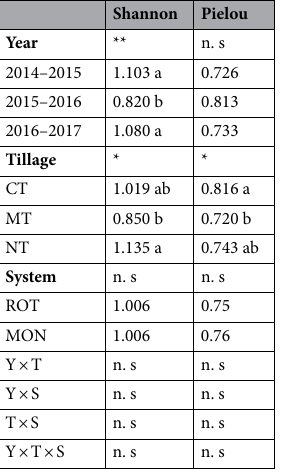
Table 4. Analysis of variance results for year, tillage system, and crop system. Mean values for Shannon and Pielou index. Different letters in each column indicate a difference between treatments according to Tukey’s HSD Test with 95% probability level ( p < 0.05); *** = 0.05; ** = 0.1; * = 0.5 CT conventional tillage, MT minimum tillage, NT no tillage, ROT rotation, MON monoculture, Y year, T tillage, S system.